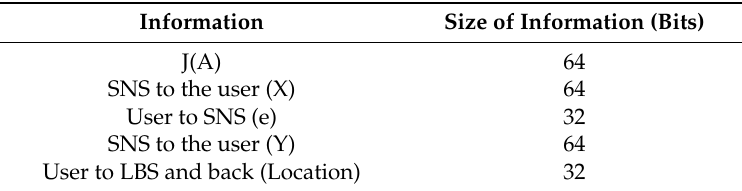
Table 3. Information size in bits.